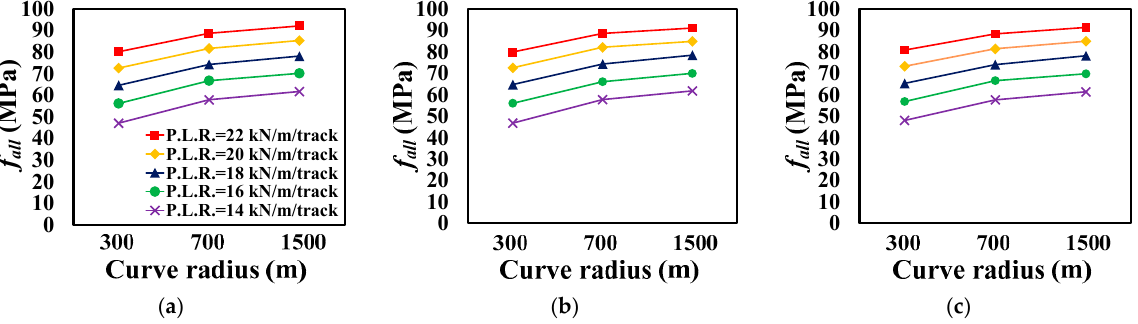
Figure 14. Effect of curve radius ( e G = 0): ( a ) L G = 9 m; ( b ) L G = 15.2 m; and ( c ) L G = 30 m.